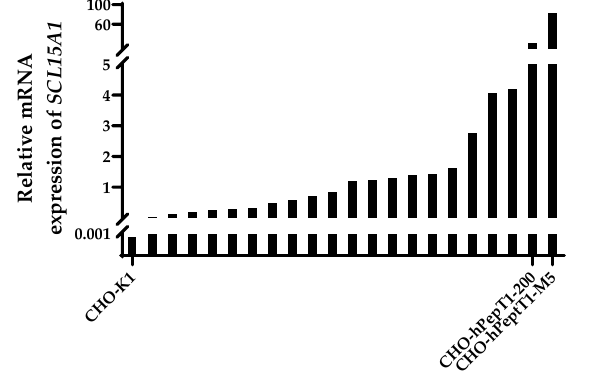
Figure 2. Relative mRNA expression of SLC15A1 in CHO-K1 and the CHO-K1 clones after transfection with SLC15A1 and selection. Data were normalised to the reference genes Fkbp1a and Mmadhc . Depicted is the mean of a technical duplicate. The two clones with the highest expression (CHO- hPepT1-200 and CHO-hPepT1-M5) were chosen for further characterisation.